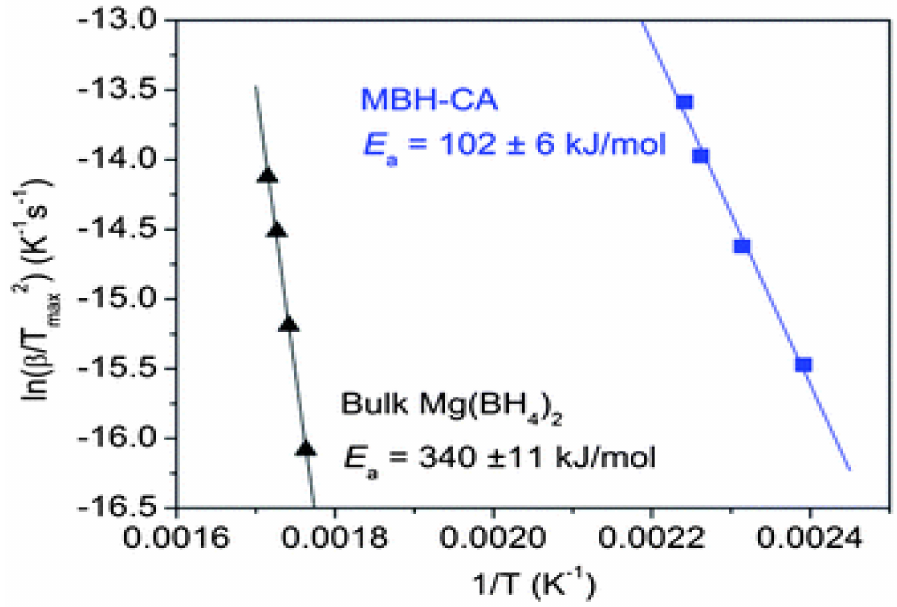
Figure 10. Kissinger analysis graph of the Mg(BH 4 ) 2 /carbon aerogel (MBH-CA) and bulk Mg(BH 4 ) 2 [135].